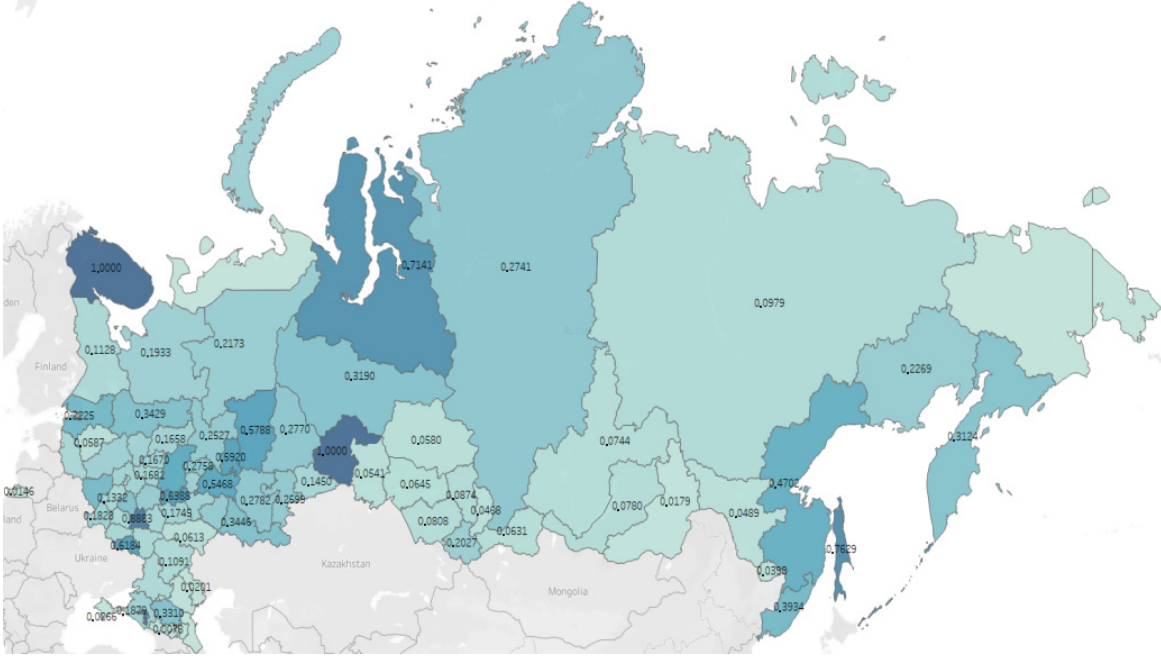
Figure 3. Map of the performance rating of RISs for 2019 (the second stage of the analysis).